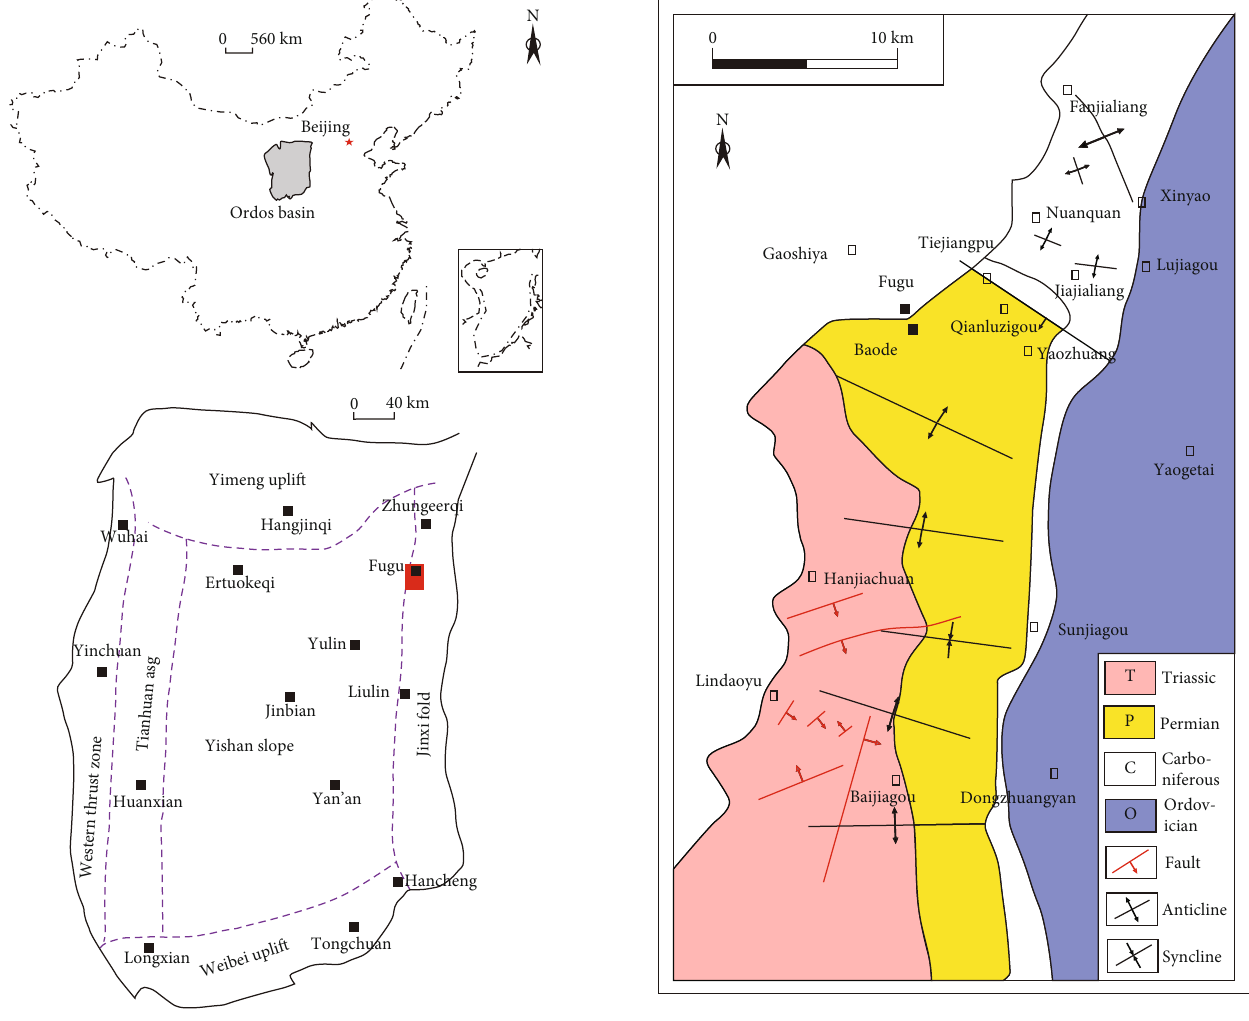
Figure 1: Geological setting of the study area. Table 1: Maceral composition of coal in the Baode area in the eastern Ordos Basin of